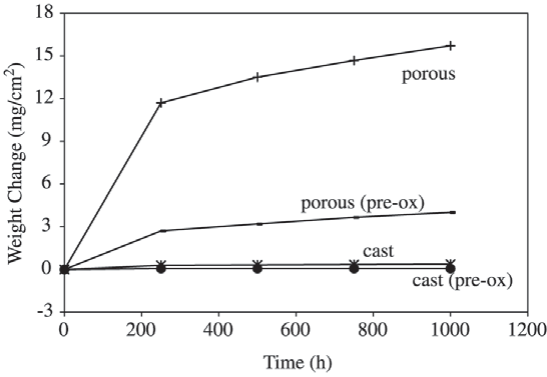
Figure 7. Corrosion test results of Ni-Cr-2xAl-Fe as cast and sintered porous samples to N (vol. %) gas for 1,000 h at 850